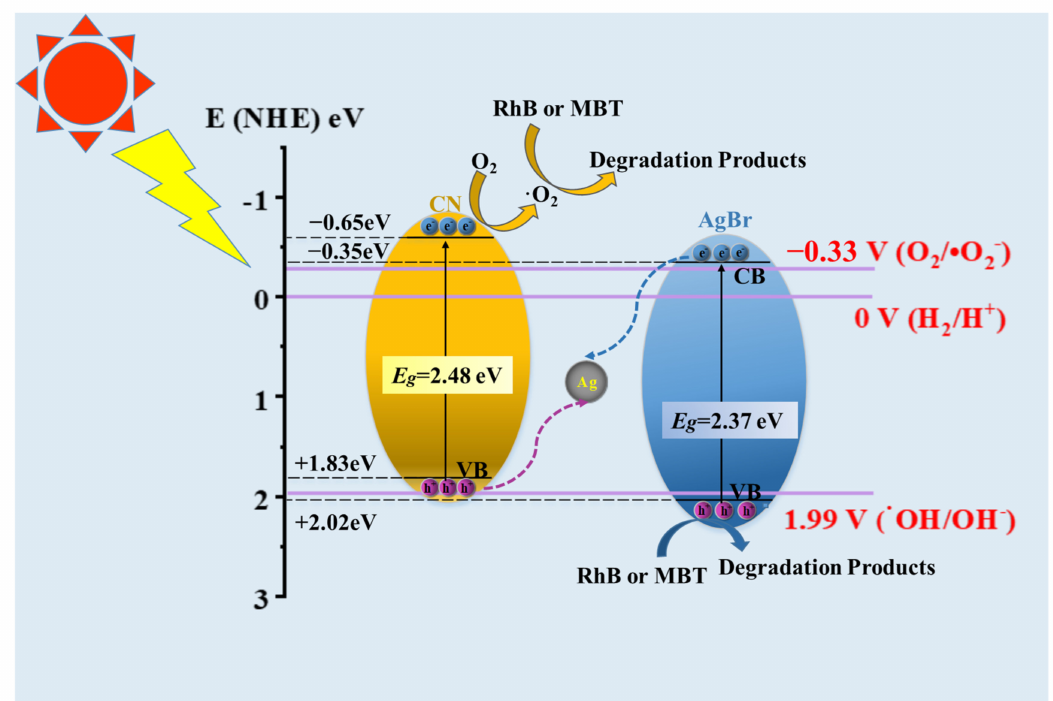
Figure 7. Schematic illustration of proposed photocatalysis mechanism of g-C 3 N 4 /AgBr-Ag compos- ites under visible light